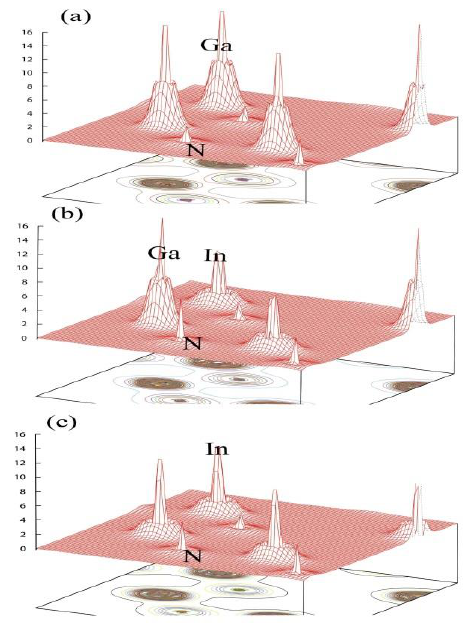
Ga N and (c) 0.5 0.5